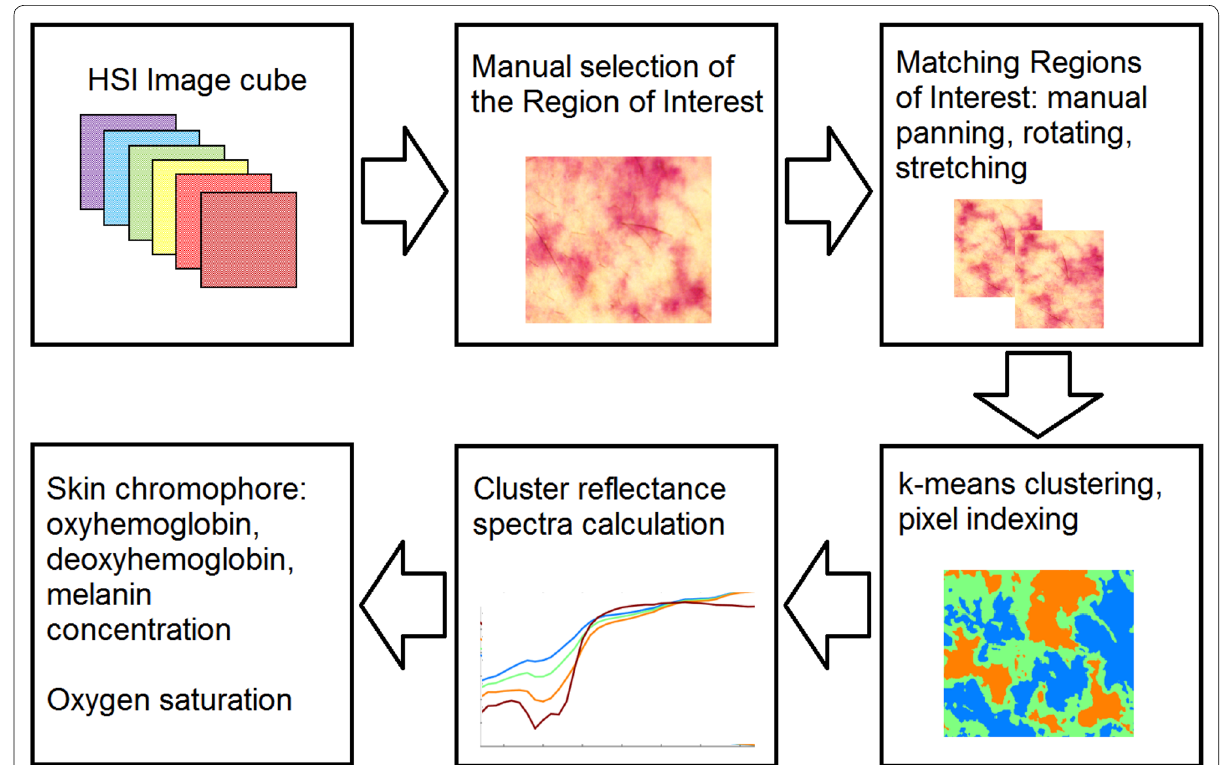
Fig. 1 Method of processing of hyperspectral imaging